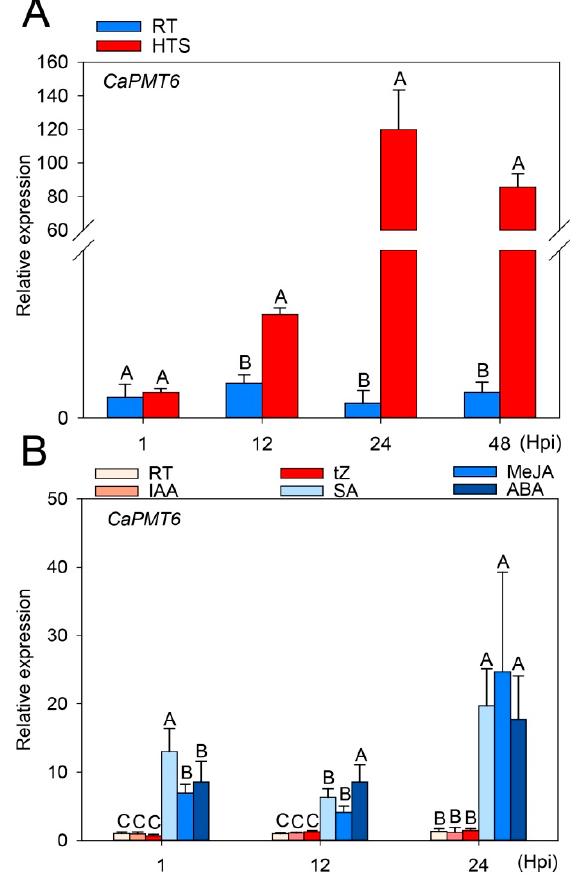
Figure 3. CaPMT6 was upregulated by HTS and by exogenous application of ABA. ( A ) The relative transcript level of CaPMT6 in pepper plants challenged by HTS. ( B ) The relative transcript level of CaPMT6 in pepper plants upon exogenously applied SA, MeJA, or ABA. In ( A , B ), CaActin was used as an internal control; data are shown as means ± standard error of six replicates; different capital letters above the bars indicated significant differences among means ( p < 0.01).